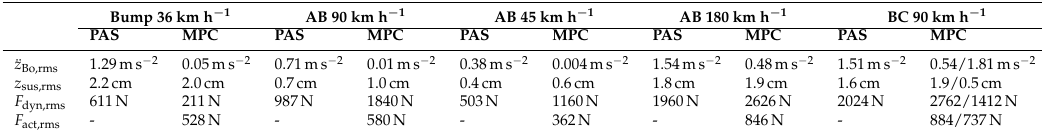
Table 9. RMS values for the passive and unrestricted MPC